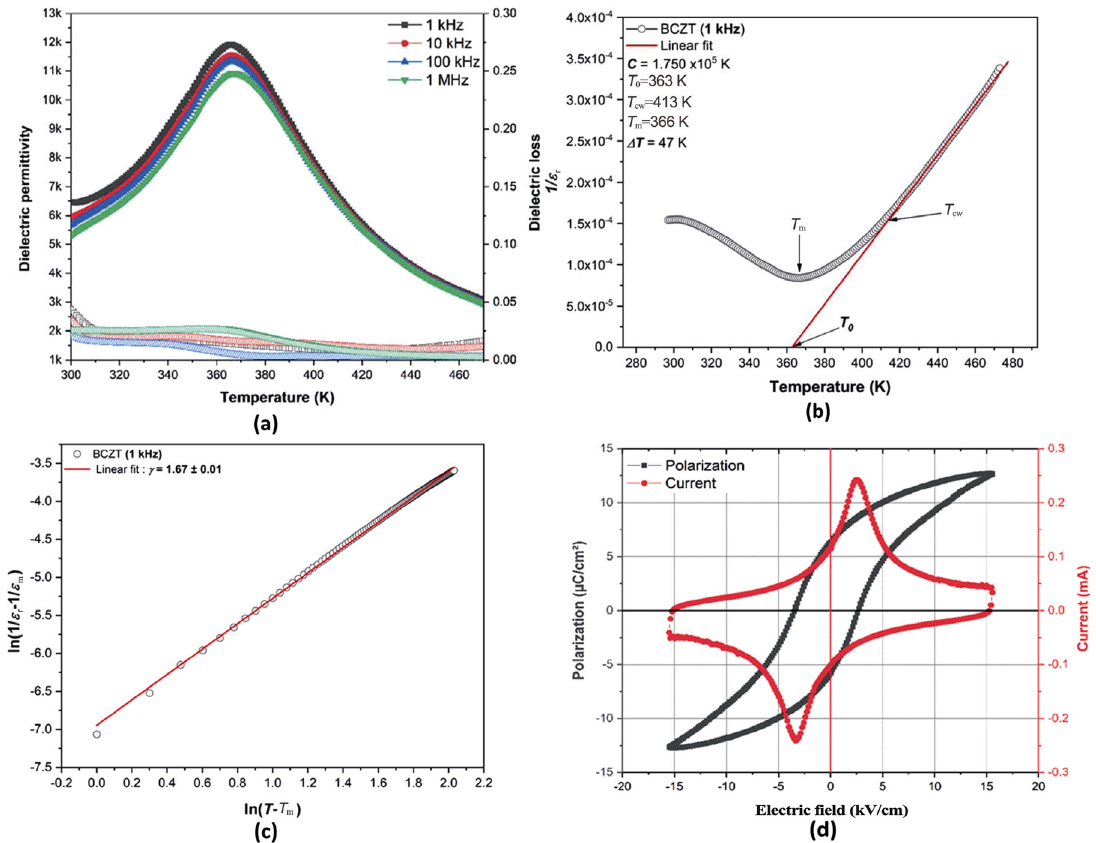
Fig. 4 (a) Temperature-dependence of dielectric constant and dielectric loss, (b, c) plots of Curie–Weiss relation and modified Curie–Weiss law to determine slope ( γ ), and (d) P – E and I – E plots of BCZT